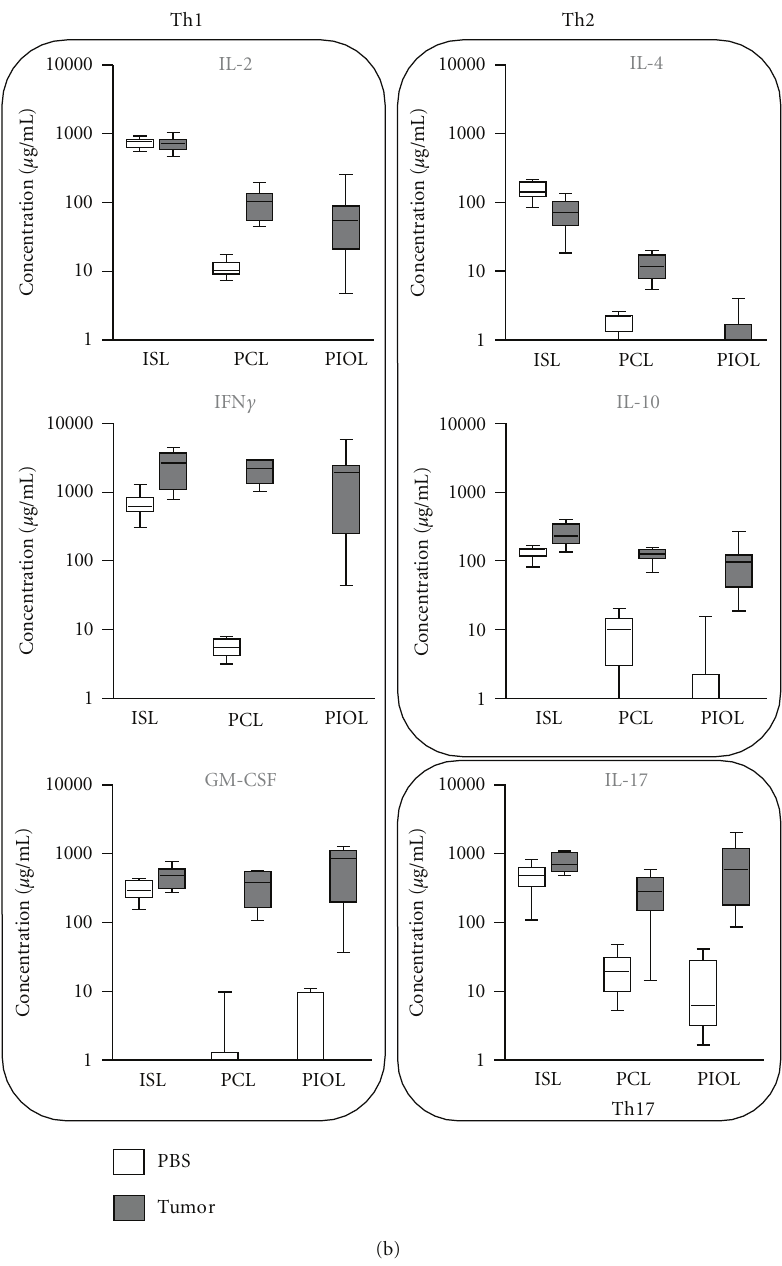
Figure 2: Comparison of the cellular and molecular immune environment of a B cell murine lymphoma implanted in the spleen, in the brain or in the eye. (a) A20.IIA-GFP cells were implanted in immunocompetent syngeneic mice in the spleen (intrasplenic lymphoma model: ISL), in the brain (primary intracerebral lymphoma model: PCL), or in the eye (primary intraocular lymphoma model: PIOL). 21 days after injection, tumor-bearing organs were analyzed by flow cytometry for the presence of GFP + tumor cells, CD3 + T lymphocytes, NKp46 + NK cells, Gr1 + neutrophils, CD11c + dendritic cells, and CD11b + CD11c − macrophages. Results are represented as the proportion of the di ff erent populations among total living cells ( n = 10). (b) 21 days after lymphoma (gray boxes) or PBS (white boxes) injection, cells were isolated from appropriate tissues and stimulated for 36 h with anti-CD3/CD28-coated Dynal beads. Secretion of IL-2, IFN γ , GM-CSF, IL-4, IL-10, and IL-17 in the culture supernatant was evaluated by cytokine bead arrays (BD Biosciences) ( n = 10). Animal studies were conformed to European Union guidelines and were approved by the Charles Darwin Ethics Committee in Animal Experiment, Paris,